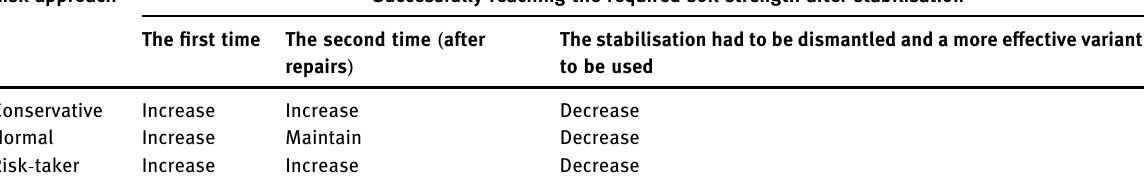
Table 3: Three types of risk approach displayed by the site manager depending on the successful strengthening of the soil; the site manager ’ s decision can result in: increasing, decreasing or maintaining the previous area of the subsequent work plot Risk approach